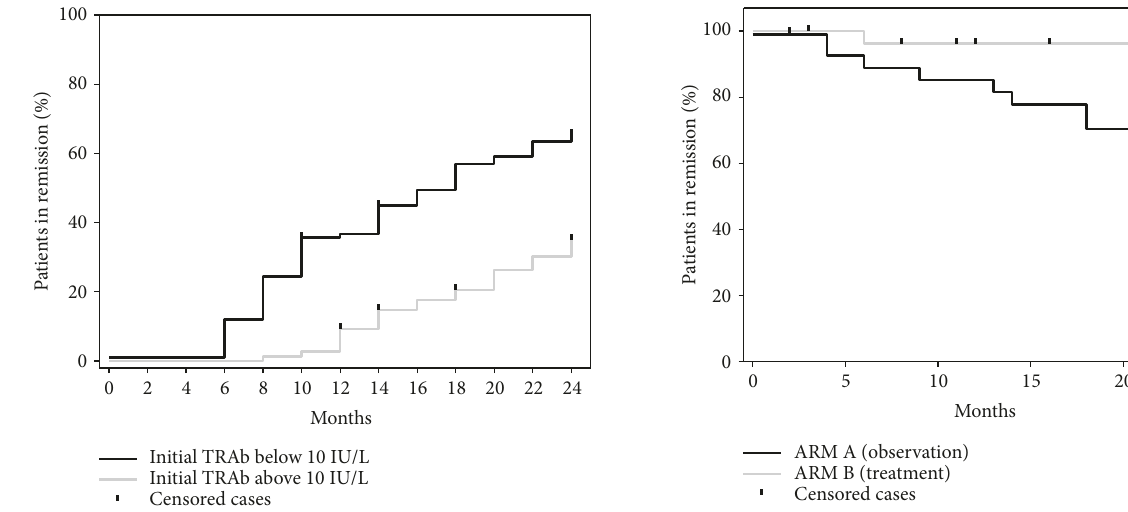
Figure 2: Event curve of patients achieving remission depending on whether initial TRAb was below (black) or above (grey) 10 IU/L. Remission was TRAb < 1.0 IU/L and TSH ≥ 0.40 mU/L on a MMI dose of 5 mg or less per day evaluated twice, two months apart.